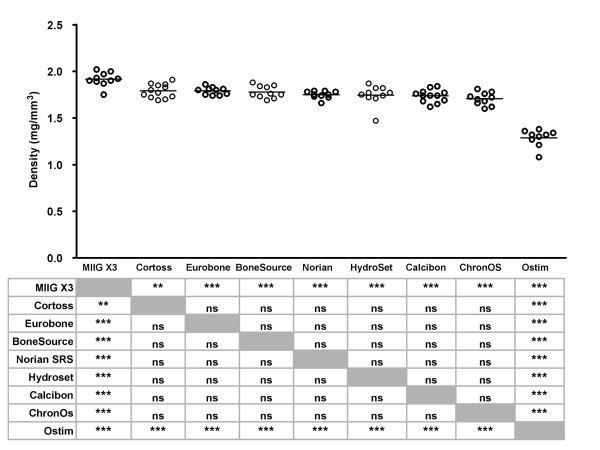
Densities of bone substitutes Densities of individual test samples were calculated from their length, diameter and weight. Each dot represents an individual test sample, and lines indicate the average value. The table below the figure provides an overview of the statistical analysis of pairwise comparisons (Student's T-test with Bonferroni correction). *, p < 0.05; **, p < 0.01; ***, p < 0.005; ns, not statistically significantly different. Grey boxes represent the self-self combinations, which could not be tested.